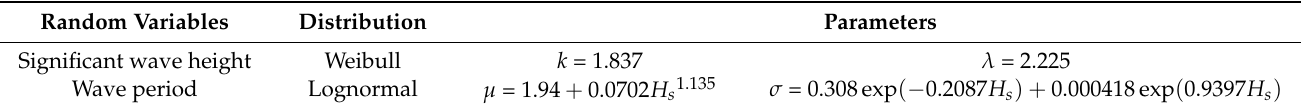
Table 5. Optimal evaluation results for different random variables distribution